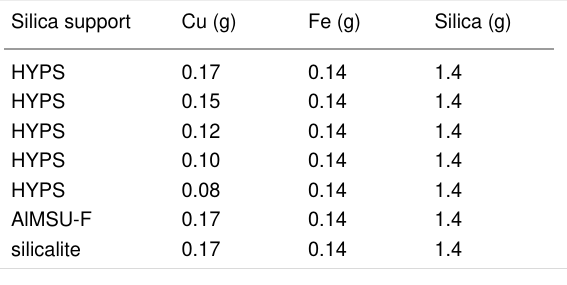
Table 2: The stoichiometric amount of CuFe 2 O 4 /silica